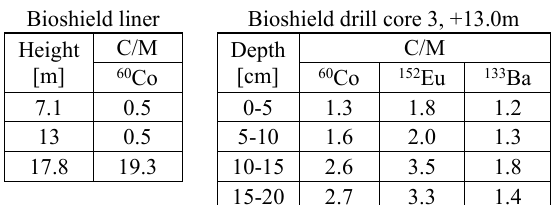
Table 1. Bioshield Activation Validation Results.